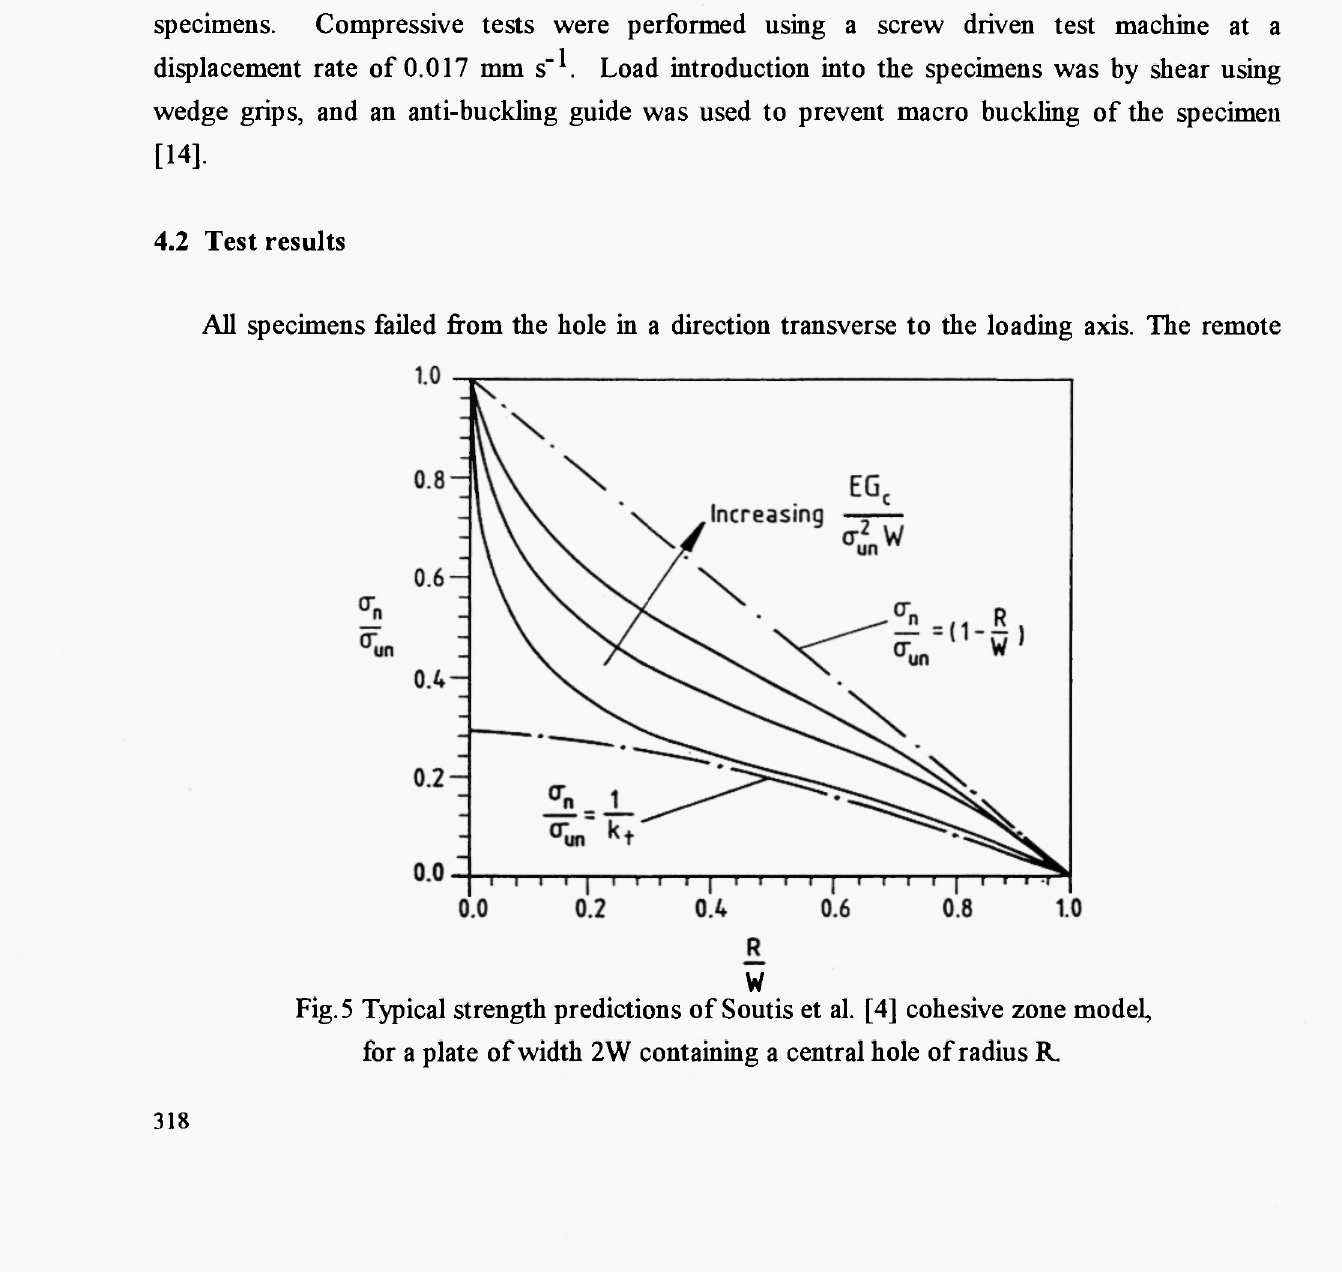
Fig. 5 Typical strength predictions of Soutis et al. [4] cohesive zone model, for a plate of width 2W containing a central hole of radius